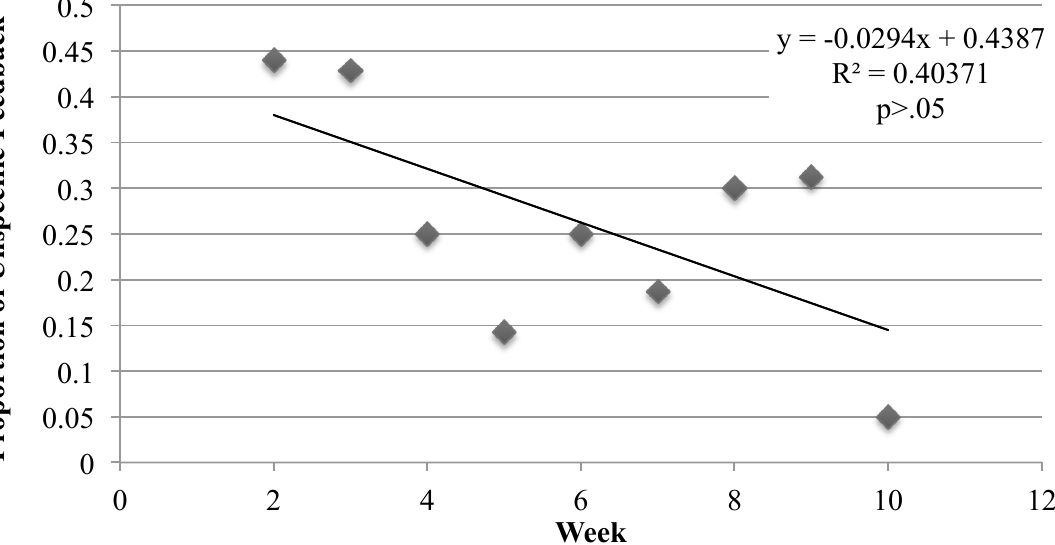
Proportion of Unspecific Feedback Given by